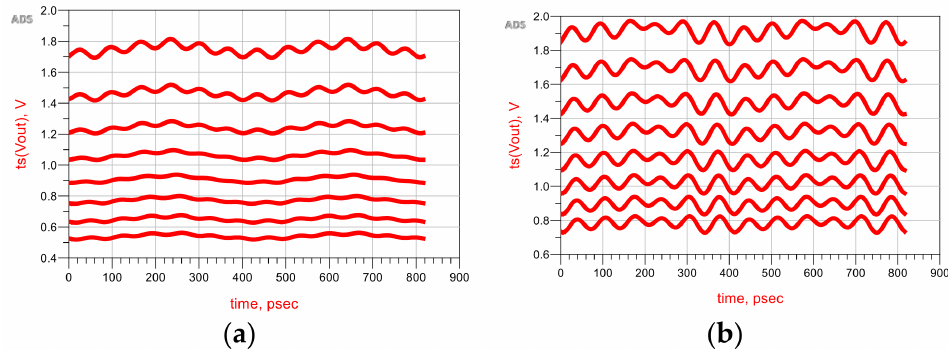
Figure 6. Single rectifier load voltage–time curve. ( a ) The load voltage–Time curve of the HSMS2820 Circuit; ( b ) the load voltage–time curve of the HSMS2860